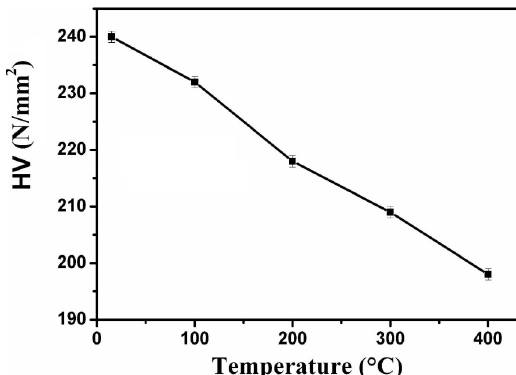
Figure 5. The variation of the hardness of the 9Cr18Mo sample with increasing temperature